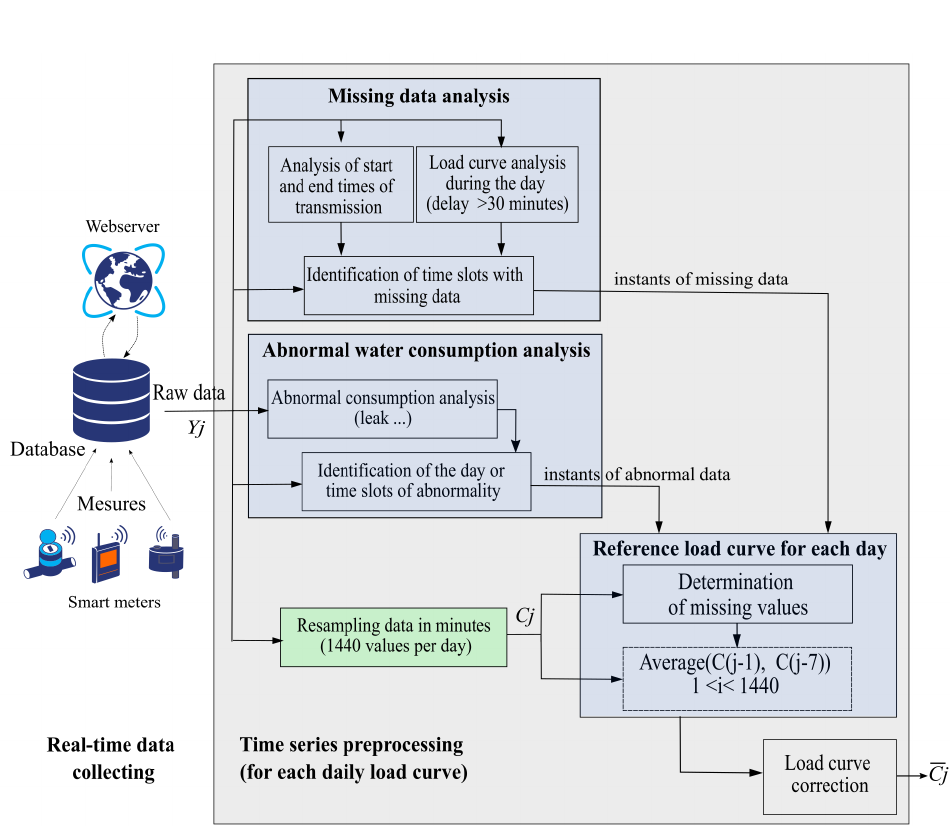
Figure 4. Global architecture of the water consumption LC